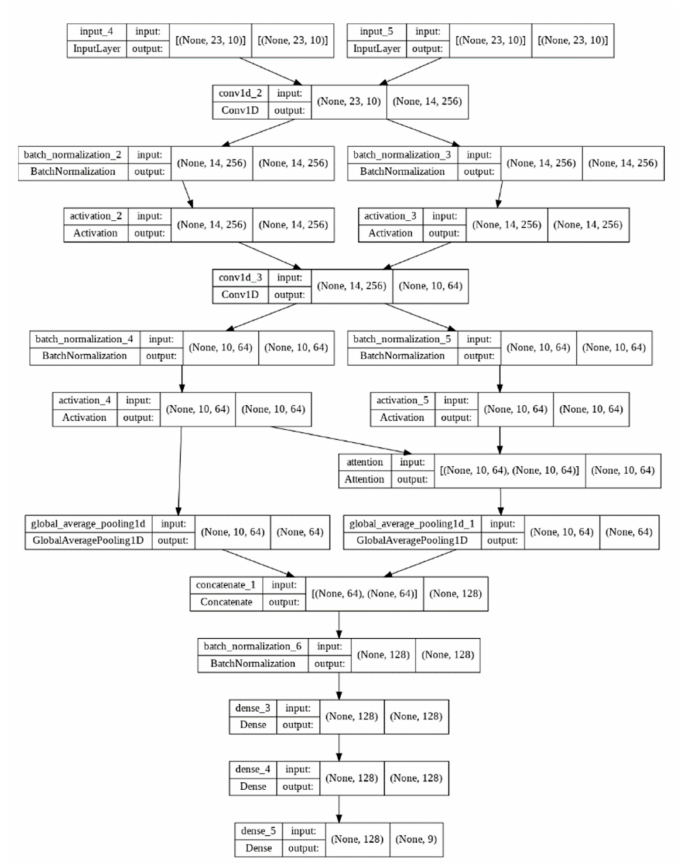
Figure A4. Attention on temporal